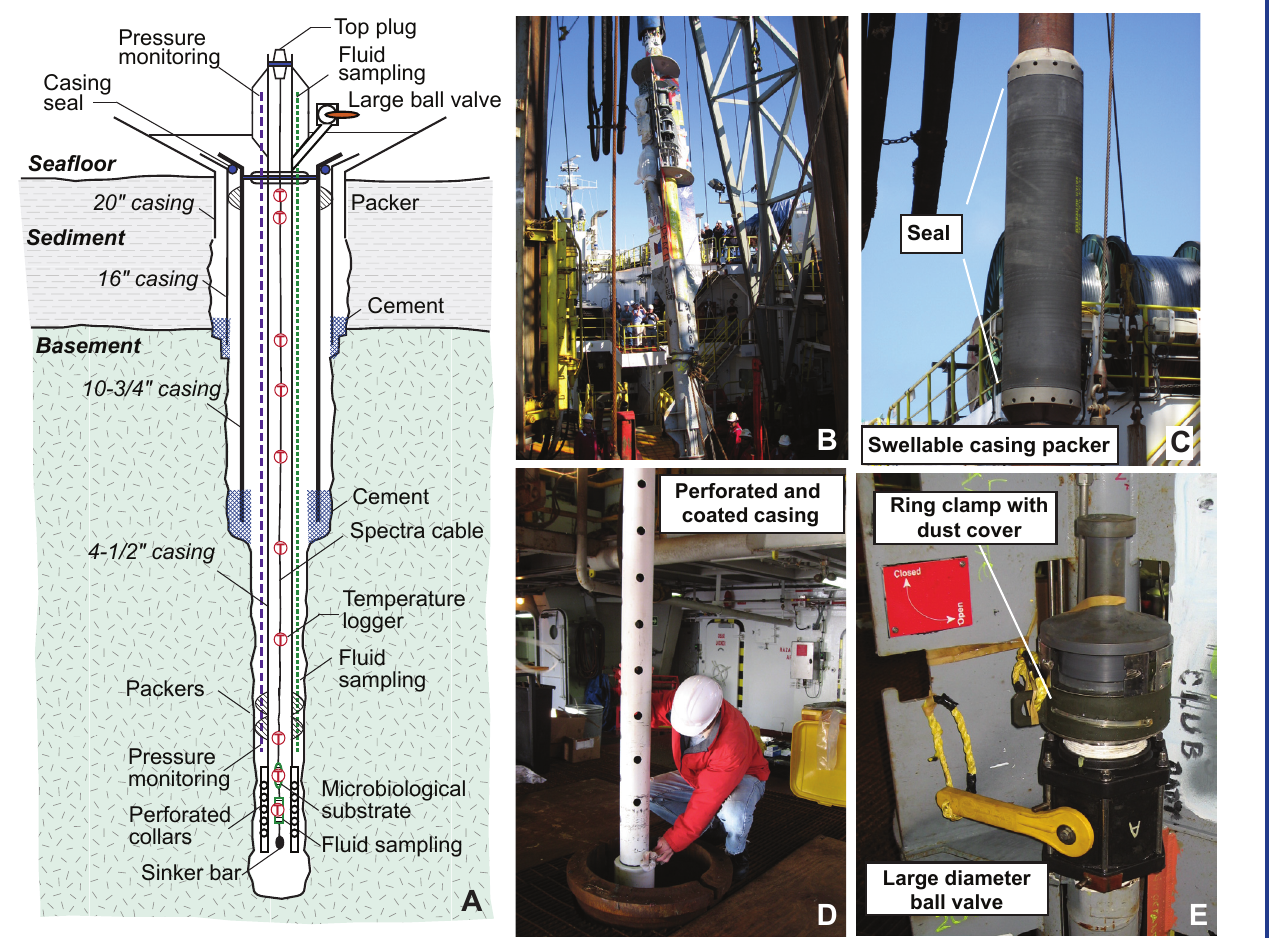
Figure 2. Diagram and photographs showing features of CORK systems deployed during IODP Expedition 327. [A] Schematic of hole completion and design of CORKs deployed in Holes U1362A and U1362B. The upper ~100 m of basement was drilled and cased to improve hole stability. Expedition 327 CORKs are built around two concentric casing strings, with multiple seals at different depths, instruments mounted on the wellhead and downhole, and the ability to monitor and sample from more than one depth interval. They also have perforated and coated drill collars and casing at depth, two kinds of CORK and casing packers (inflatable and swellable), and a ball valve above a lateral pipe that can be used for long-term free-flow experiments. Downhole temperatures are recorded with autonomous sensor and logging instruments incorporated into the fluid and microbiological samplers or hung independently from a cable. [B] CORK wellhead being hoisted on the rig floor during Expedition 327. [C] Swellable packer element, which expands during reaction with fluid in the borehole to seal against casing or the open formation. [D] Perforated and coated casing being cleaned with alcohol prior to deployment. [E] Ball valve in wellhead to be used for free-flow experiment and